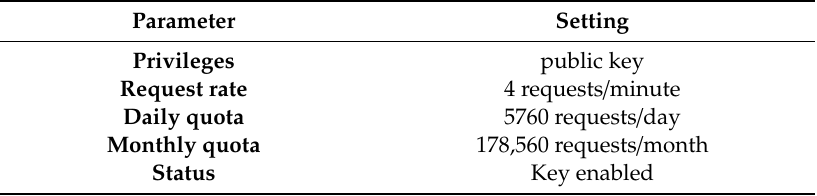
Table 1. Limitations of VirusTotal public Application Programming Interface